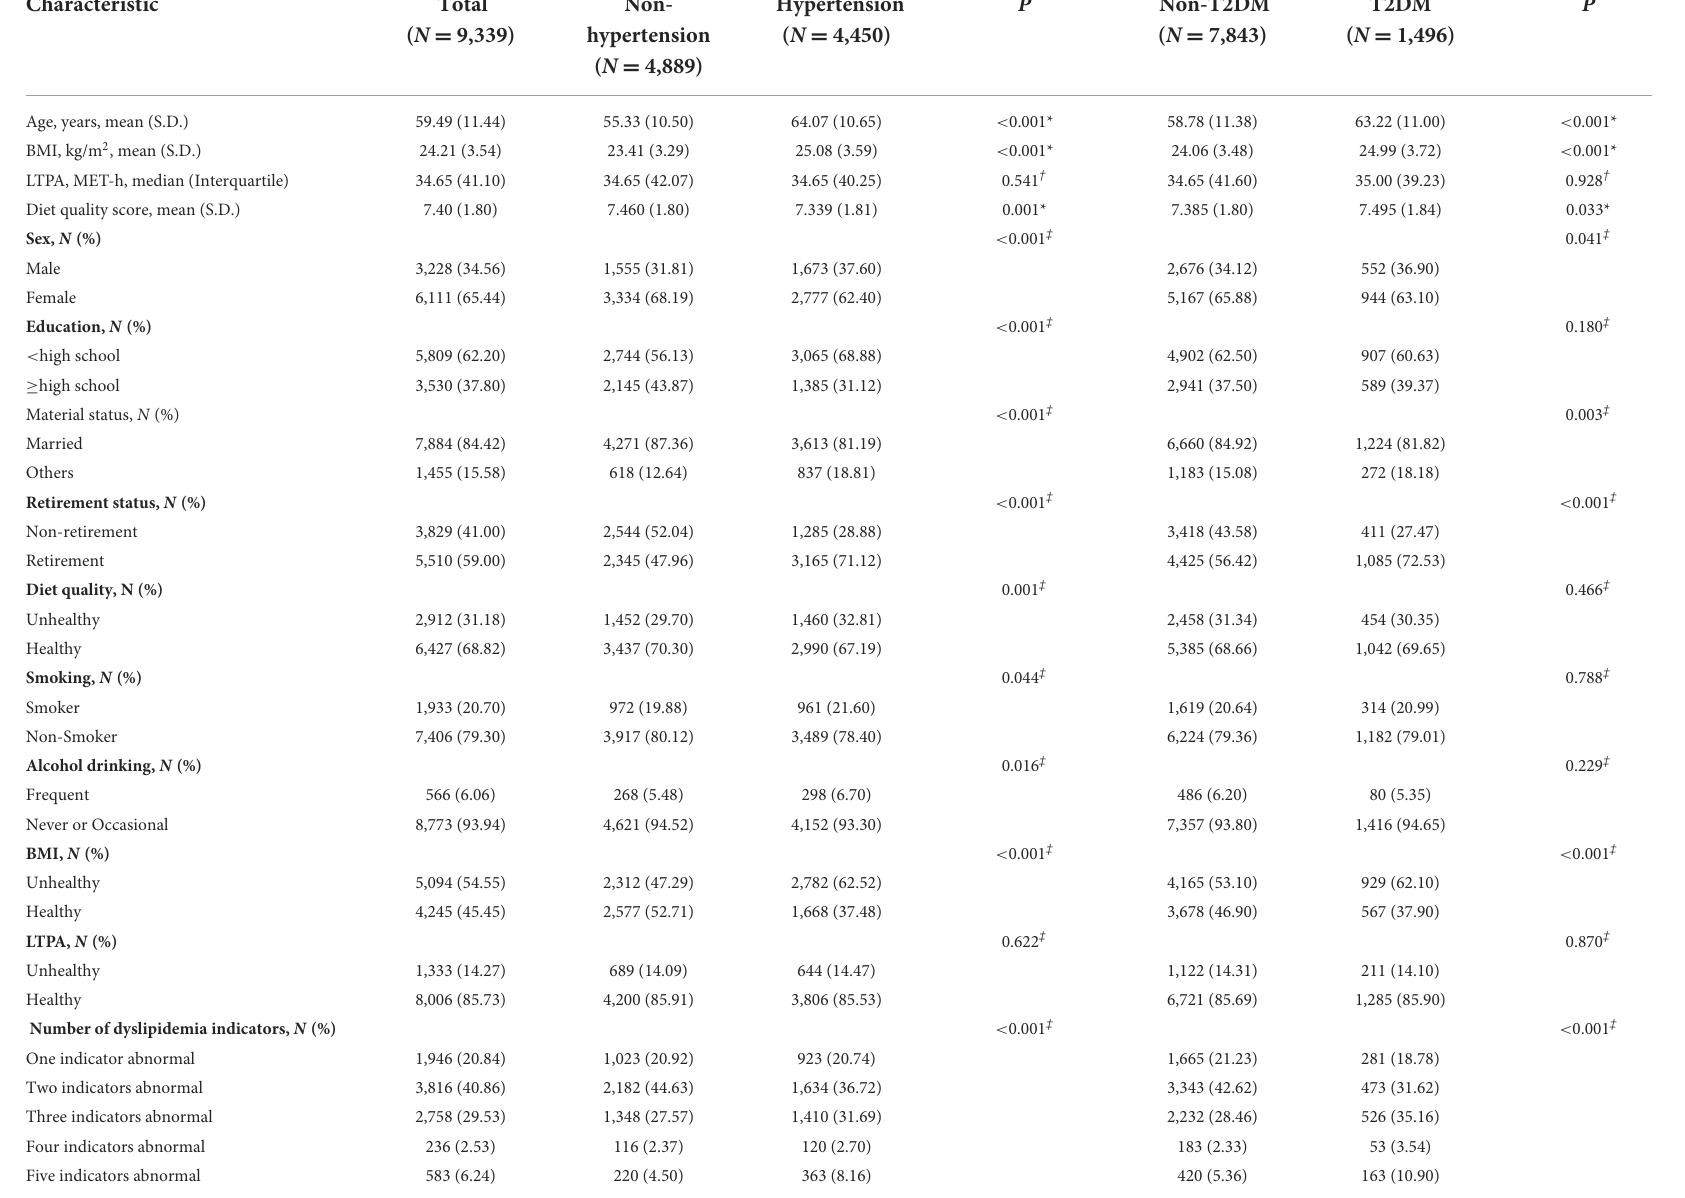
TABLE 2 Baseline characteristic of the subjects with dyslipidemia.